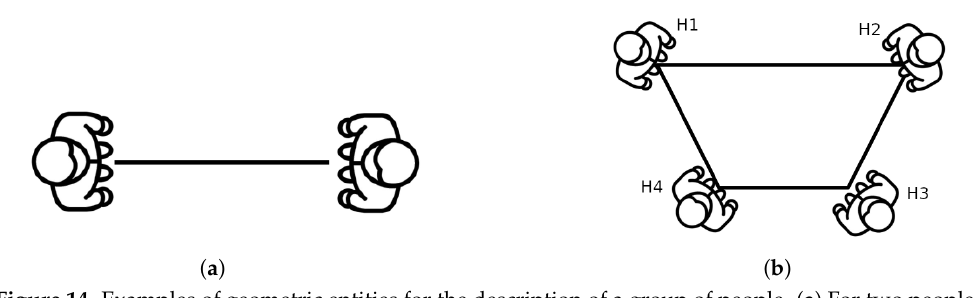
Figure 14. Examples of geometric entities for the description of a group of people. ( a ) For two people, the only geometric entity is a line; ( b ) For multiple people, the geometric entity will depend on their